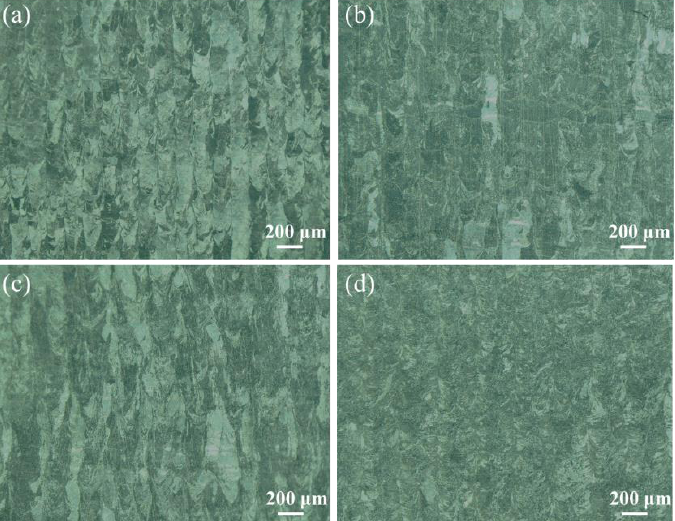
Figure 4. Morphologies of grains under optical microscopy from side view (in XOZ section): ( a ) 200 W power and 600 mm/s scanning velocity; ( b ) 200 W power and 800 mm/s scanning velocity; ( c ) 320 W power and 600 mm/s scanning velocity; ( d ) 320 W power and 800 mm/s scanning velocity. It can also be seen from Figure 3 and 4 that columnar grains and equiaxed grains were arranged in sequence along the Y-direction, the equiaxed grains were formed along the center line of the laser track, and epitaxially grown columnar coarse grains penetrated through multiple deposition layers; meanwhile, the width of these columnar grains was about 85 µm, which matched the hatch spacing well. It is worth noting that the direction of epitaxial growth of the columnar grains was not perpendicular to the deposition direc- tion, which is related to the direction of heat diffusion during the solidification of the mol- ten pool. The authors believe that there is a temperature gradient in the molten pool from the center of the molten pool to the outside during the solidification process which,